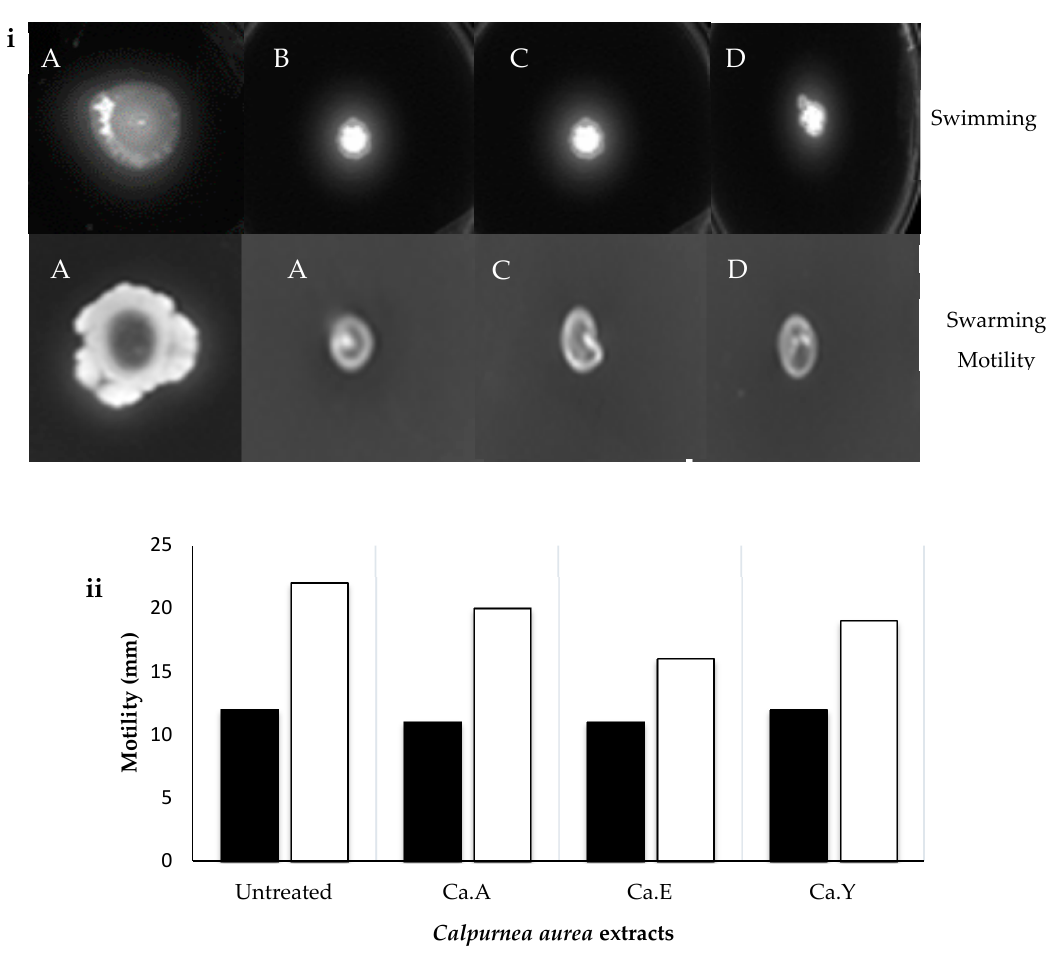
Figure 8. Representative images ( i ) and bar graph ( ii ) of P. aeruginosa (ATCC 9721) swimming (closed bars) and swarming (open bars) motility in the presence of various plant extracts (1 mg / mL) after 24 h at 37 ◦ C incubation. Top row: swimming motility and bottom row: swarming motility. ( A ) negative control (untreated bacteria), and ( B – D ) represents P. aeruginosa treated with C. aurea ethanol, acetone, and ethyl acetate, respectively. Ca.E—Ethanol, Ca.A—Acetone, and Ca.Y—Ethyl acetate extracts. Data presented as averages.